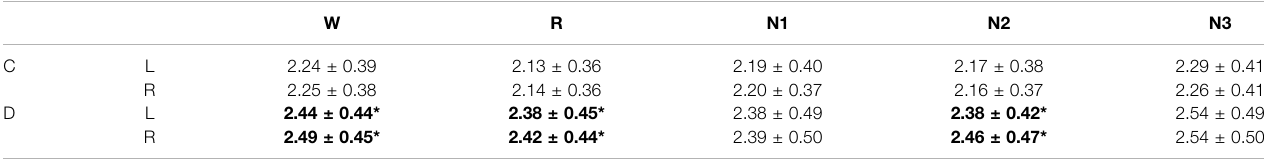
Bold numbers and * indicate signi fi cant difference ( p < 0.05). L, left hemisphere; R, right hemisphere; C, control group; D, depressed